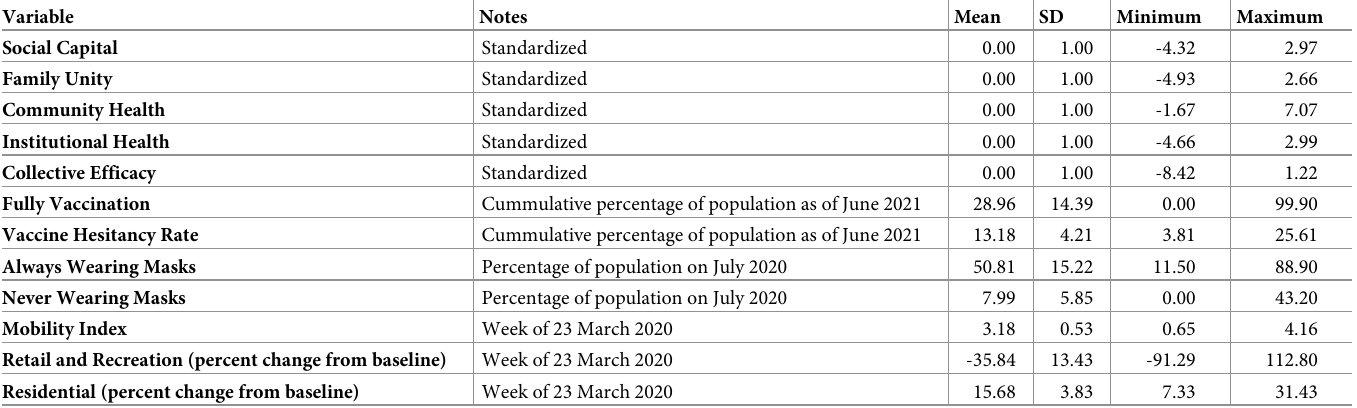
Table 1. List of variables and descriptives.